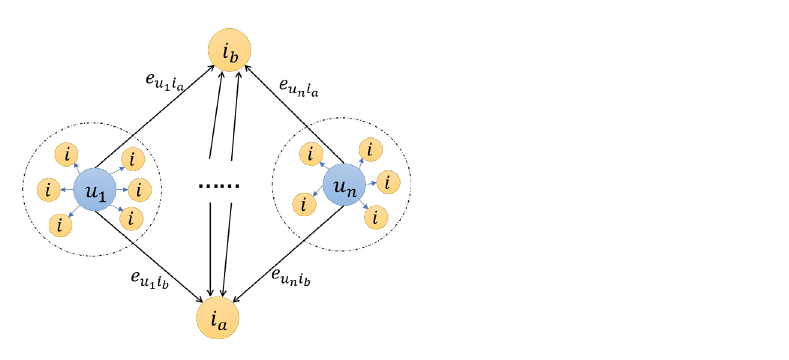
Figure 2. The principal figure of item–item relation information aggregation.